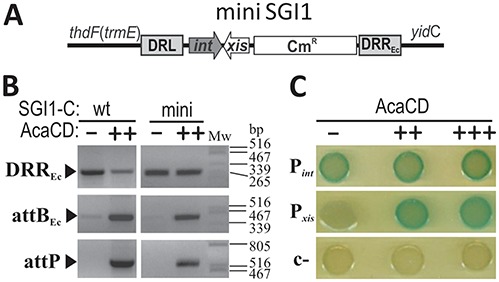
Localization of AcaCD target region in SGI1. (A) Schematic representation of mini SGI1 residing on the E. coli chromosome. (B) AcaCD-induced excision of wt SGI1-C (wt) and miniSGI1 (mini) in TG1Nal strain. The activator was expressed from pJKI828 (++). Vector pJKI691 (−) was used as negative control. (C) AcaCD activates expression from the upstream region of xis gene. Non-coding upstream regions of int and xis were fused with a promoterless lacZ gene in β-gal tester plasmids. Constructs pJKI995 (Pint), pJKI1003 (Pxis) and pJKI990 (c−) were monitored for lacZ expression in the presence or absence of AcaCD by drop test. The activator was expressed from its own promoter (pJKI828, ++) or Ptac (pJKI888, +++). Vector pJKI691 (−) was used as negative control.